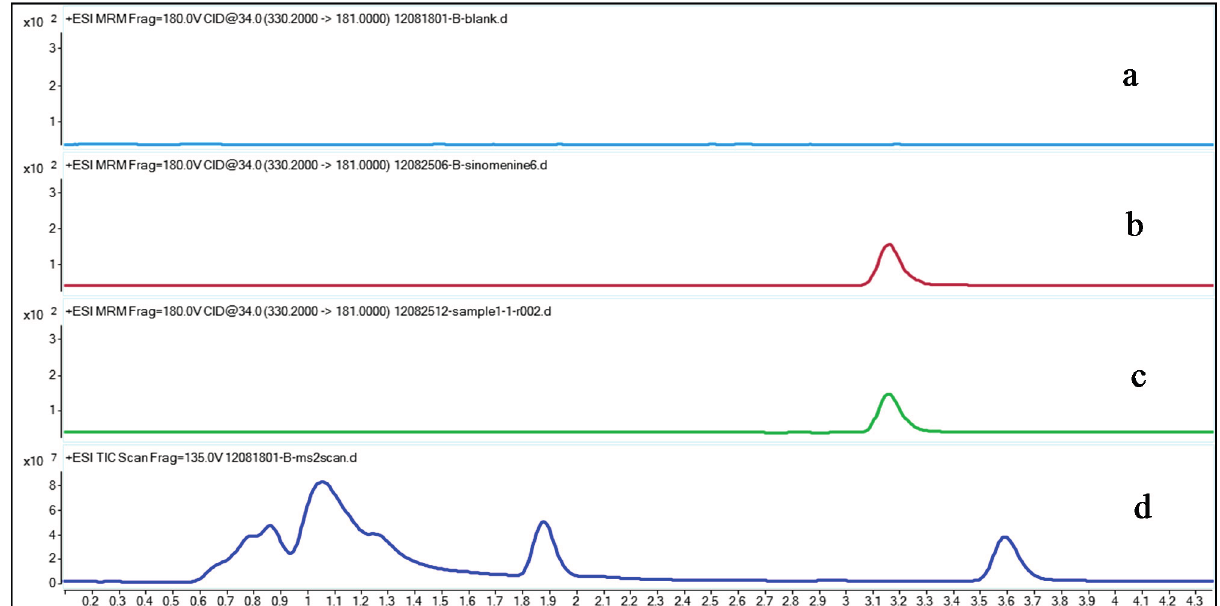
Figure 2. Typical multiple reaction-monitoring (MRM) chromatograms of sinomenine and MS2 scan chromatogram of drug-free plasma. (a) Drug-free plasma; (b) Pre-spiked sinomenine in the drug-free control plasma with a final concentration of 1.878 ng/mL; (c) Sample from a rheumatoid arthritis (RA) patient 30 min after transdermal delivery of the Fengtongning (FTN) injection; (d) MS2 scan result of drug-free